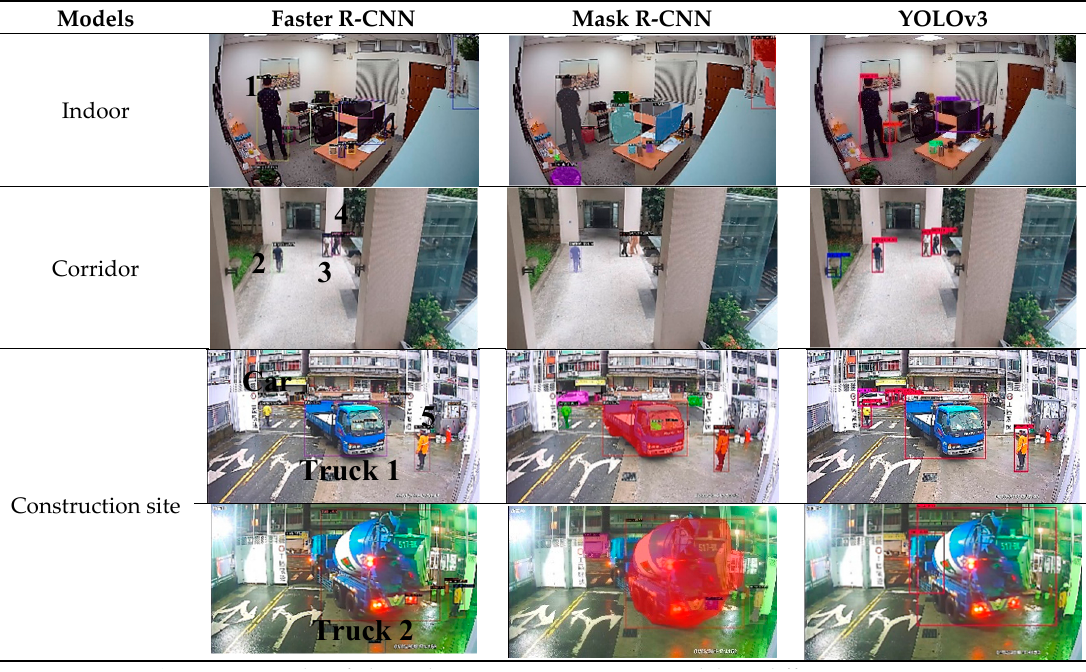
Figure 13. Results of object detection using various models in different scenarios. Table 4. Results of geometric measurement using various models in di ff erent